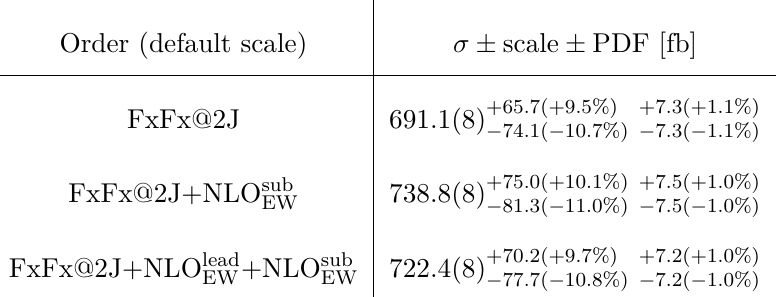
Table 4 . Addition of the EW corrections to the merged cross section. The error in parenthesis is the absolute MC-error on the last digit of the central value. The scale and PDF uncertainties are shown in the form of ±{ absolute scale } ( ±{ relative scale in % } ) ±{ absolute PDF } ( ±{ relative PDF in % } )